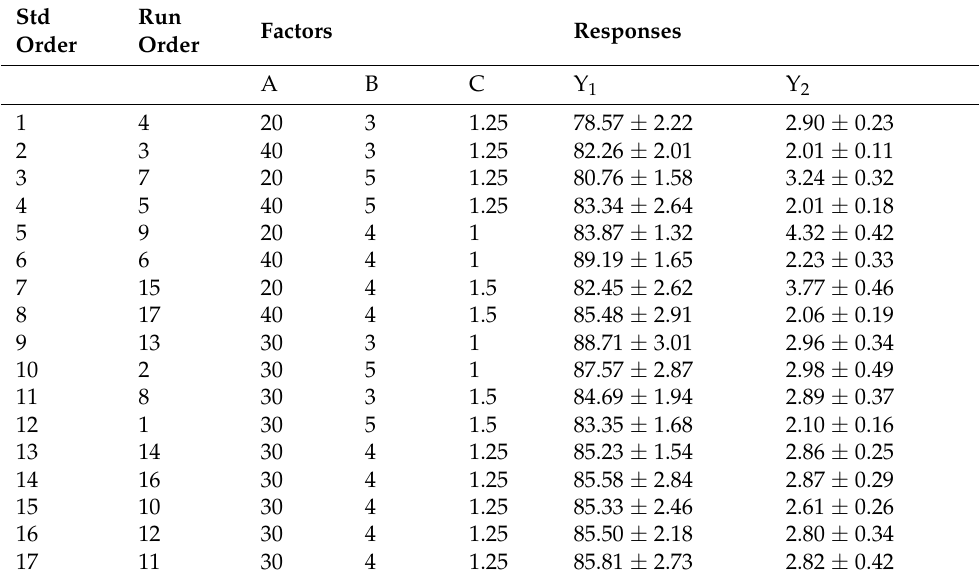
A: ratio of lipid and drug; B: ratio of solid lipid and liquid lipid; C: surfactant concentration; Y 1 = EE (%); Y 2 = DL (%).